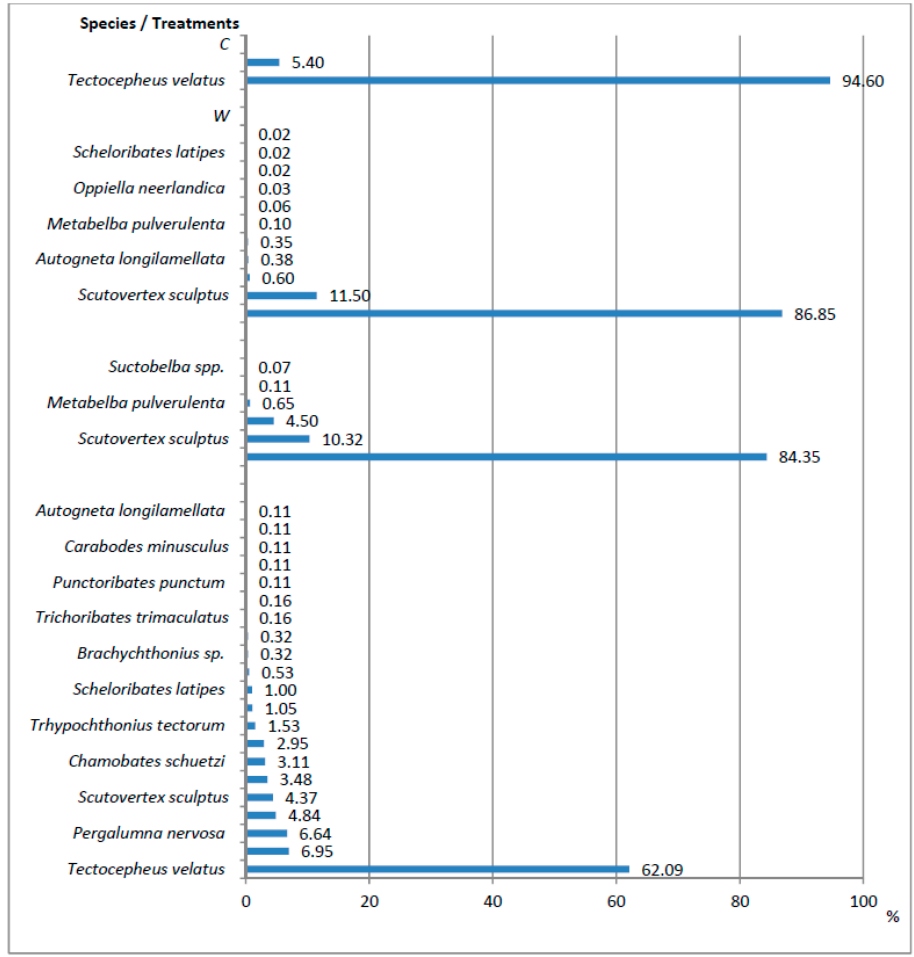
Figure 1. Domination index of the oribatid mites in the particular experiment treatments. Where: C = control—without mulching ( Tectocepheus velatus (Michael): Tectocepheuidae; Oribatula tibialis (Nicolet): Oribatulidae); W = soil mulched with wood chips ( Tectocepheus velatus (Michael): Tectocepheuidae; Scutovertex sculptus Michael: Scutoverticidae; Oppiella nova (Oudemans): Oppiidae; Autogneta longilamellata (Michael): Autognetidae; Suctobelba spp. Paoli: Suctobelbidae; Metabelba pulverulenta (C. L. Koch): Damaeidae; Camisia biurus (C. L. Koch): Camisiidae; Oppiella neerlandica (Oudemans): Oppiidae; Trichoribates trimaculatus (C. L. Koch): Ceratozetidae; Scheloribates latipes (C. L. Koch): Scheloribatidae; Liochthonius spp. van der Hammen: Brachychthoniidae); WM = soil mulched with wood chips with the addition of mycorrhiza preparation ( Tectocepheus velatus (Michael): Tectocepheuidae; Scutovertex sculptus Michael: Scutoverticidae; Oppiella nova (Oudemans): Oppiidae; Metabelba pulverulenta (C. L. Koch): Damaeidae; Camisia segnis (Hermann): Camisiidae; Suctobelba spp. Paoli: Suctobelbidae); WL = soil mulched with wood chips with the addition of forest litter ( Tectocepheus velatus (Michael): Tectocepheuidae; Oppiella nova (Oudemans): Oppiidae; Pergalumna nervosa (Berlese): Galumnidae; Eremaeus oblongus C. L. Koch: Eremaeidae; Scutovertex sculptus Michael: Scutoverticidae; Metabelba pulverulenta (C. L. Koch): Damaeidae; Chamobates schuetzi (Oudemans): Chamobatidae; Oribatula tibialis (Nicolet): Oribatulidae; Trhypochthonius tectorum (Berlese): Trhypochthoniidae; Oppiella neerlandica (Oudemans): Oppiidae; Scheloribates latipes (C. L. Koch): Scheloribatidae; Suctobelba spp. Paoli: Suctobelbidae; Brachychthonius sp. Berlese: Brachychthoniidae; Banksinoma lanceolata (Michael): Thyrisomidae; Trichoribates trimaculatus (C. L. Koch): Ceratozetidae; Scheloribates laevigatus (C. L. Koch): Scheloribatidae; Punctoribates punctum (C. L. Koch): Punctoribatidae; Carabodes subarcticus Tragardh: Carabodidae; Carabodes minusculus Berlese: Carabodidae; Camisia horrida (Hermann): Camisiidae; Autogneta longilamellata (Michael):